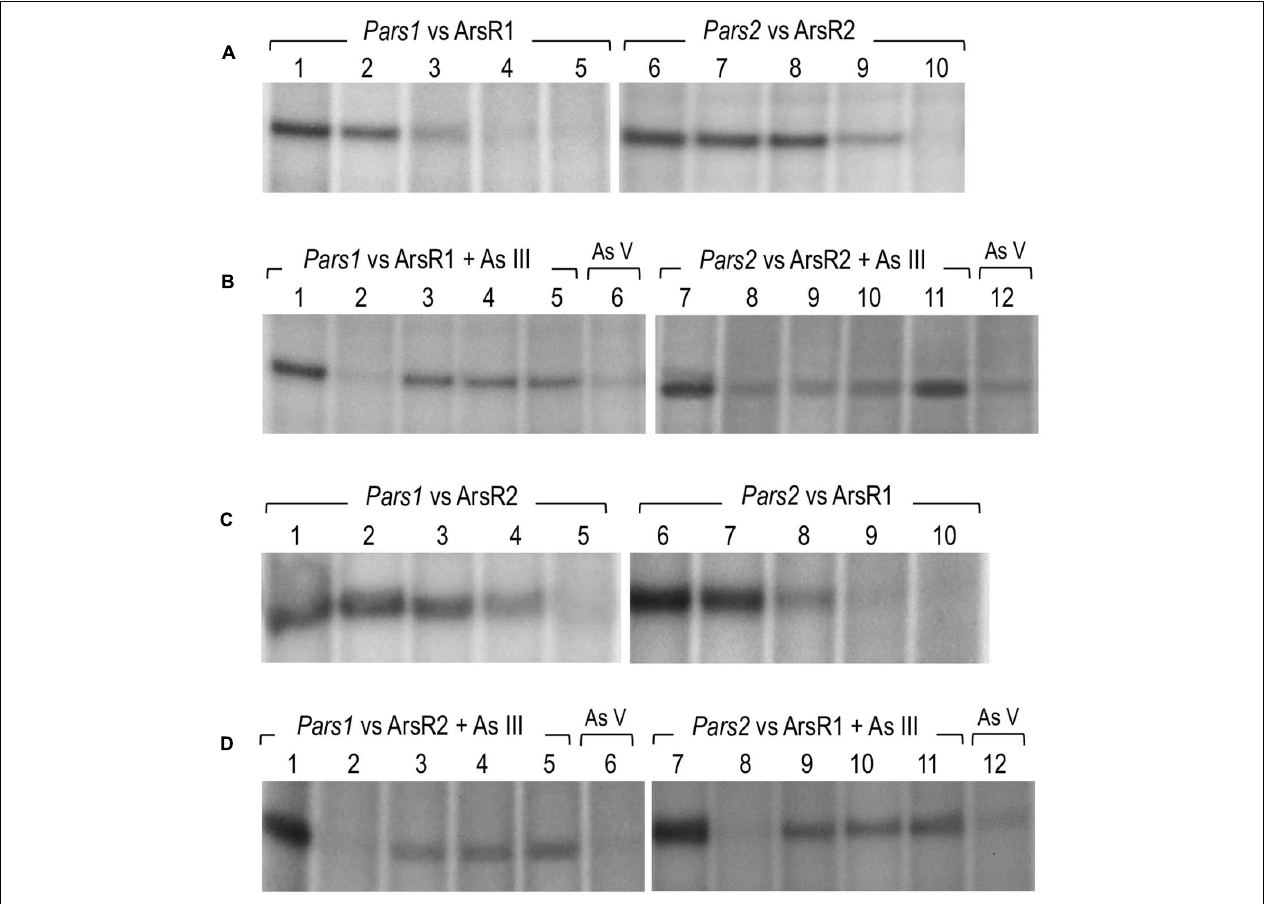
FIGURE 6 | In vitro transcription showing the activity of the Pars1 and Pars2 promoters. Multiple-round transcription reactions were carried out by using plasmid pJCD harboring Pars1 and Pars2 promoter’s templates, as indicated, that produce an mRNA of 205 and 184 nucleotides, respectively. All the in vitro transcription reactions were performed with 40 nM Pseudomonas putida RNAP. (A) Effect of 6His-ArsR1 and 6His-ArsR2 proteins on Pars1 and Pars2 promoters, respectively. Lanes 1 to 5 were loaded with 0, 20, 50, 100, and 200 nM of 6His-ArsR1, and lanes 6 to 10 were loaded with 0, 20, 50, 100, and 500 nM of 6His-ArsR2. (B) Effect of As (III) and As (V) addition on the action of 6His-ArsR1 and 6His-ArsR2 on Pars1 and Pars2 promoters. Lanes 1 and 7 were loaded without any protein. Lanes 2 to 6 and 8 to 12 were performed with 100 nM of 6His-ArsR1 and 500 nM of 6His-ArsR2, respectively. Lanes 2 to 5 and 8 to 11 were performed with 0, 0.1, 0.5, and 2 mM of arsenite (AsIII), respectively. Lanes 6 and 12 correspond to samples with 2 mM of arsenate (AsV). (C) Effect of 6His-ArsR2 and 6His-ArsR1 proteins on Pars1 and Pars2 promoters, respectively. Lanes 1 to 5 were loaded with 0, 20, 50, 100, and 500 nM of 6His-ArsR2, and lanes 6 to 10 were loaded with 0, 20, 50, 100, and 200 nM of 6His-ArsR1. (D) Effect of As (III) and As (V) addition on the action of 6His-ArsR2 and 6His-ArsR1 on Pars1 and Pars2 promoters. Lanes 1 and 7 were loaded without any protein. Lanes 2 to 6 and 8 to 12 were performed with 100 nM of 6His-ArsR1 and 500 nM of 6His-ArsR2, respectively. Lanes 2 to 5 and 8 to 11 were performed with 0, 0.1, 0.5, and 2 mM of arsenite (AsIII), respectively. Lanes 6 and 12 correspond to samples with 2 mM of arsenate